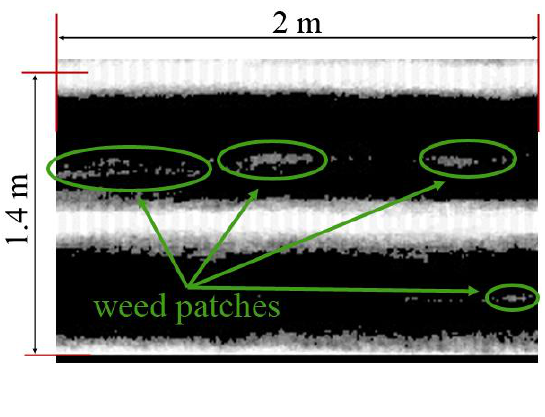
Figure 8. Crop area in the first video sequence in which weeds are present. Due to the large scale of the maps, a more appropriate resolution is needed in order to detect the occurrence of